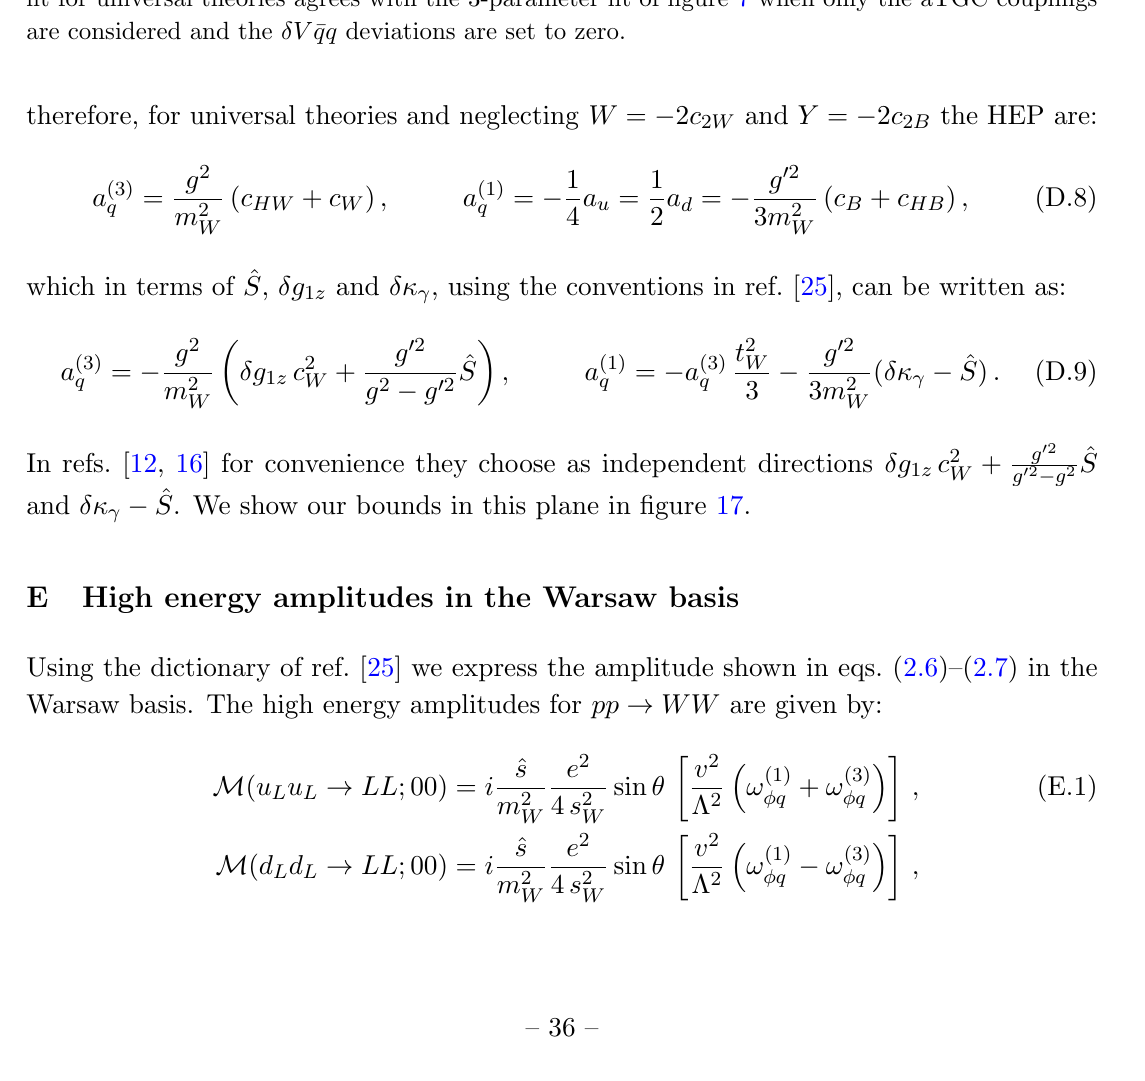
Figure 17 . 95%CL constraints on universal theories with W; Y (cid:28) 1. Left: comparison of the LEP constraints with the ones extracted from the current LHC diboson data (dotted) and the HL-LHC projections (solid). Right: constraints of this work compared with the ones in refs. [12, 16]. This (cid:12)t for universal theories agrees with the 3-parameter (cid:12)t of (cid:12)gure 7 when only the aTGC